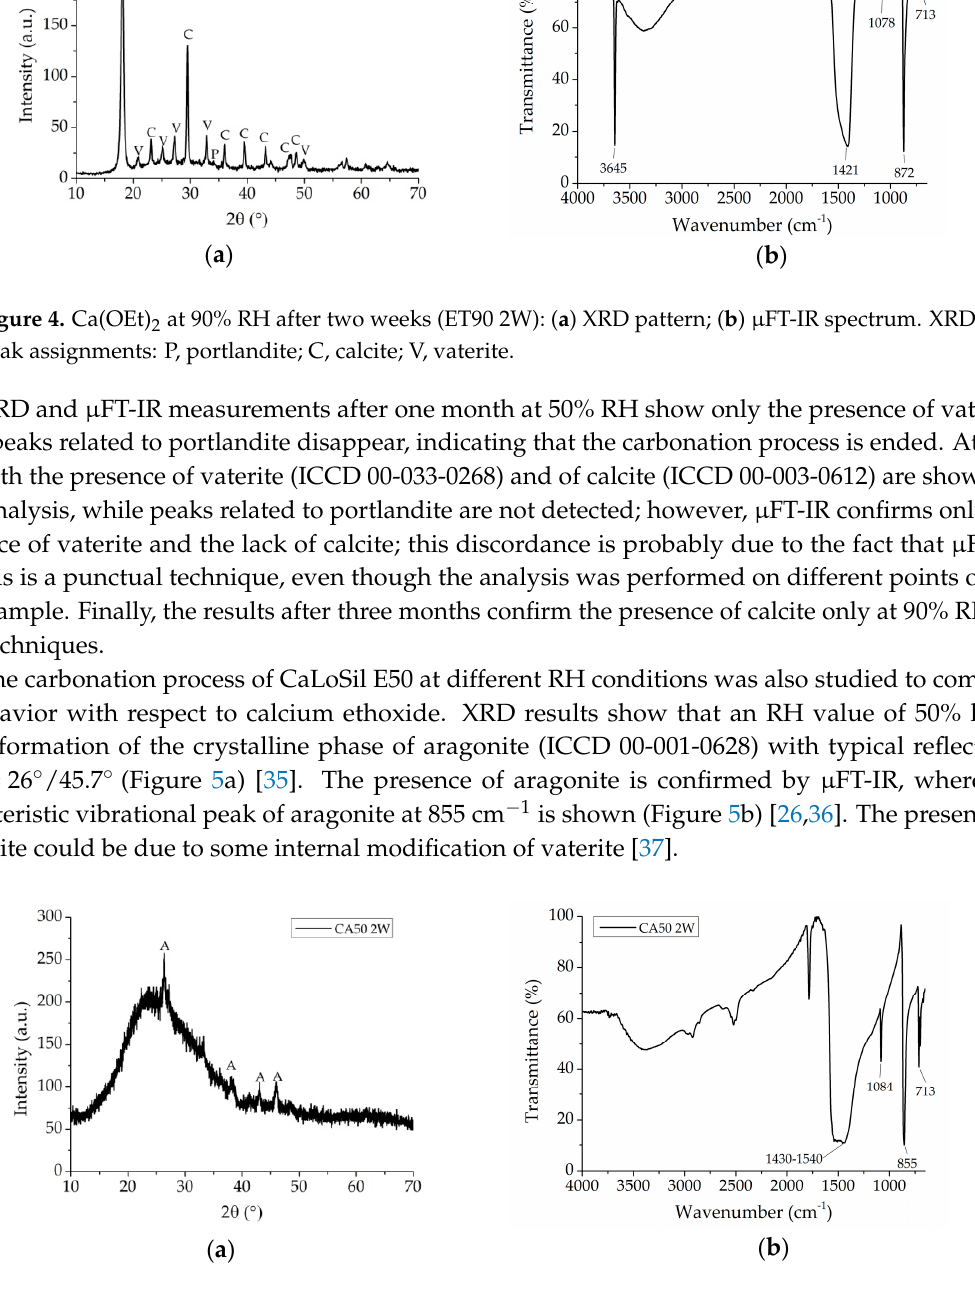
Figure 5. CaLoSilE50 at 50% RH after two weeks (CA50 2W): ( a ) XRD pattern; ( b ) μ FT-IR spectrum. XRD peak assignments: A, aragonite